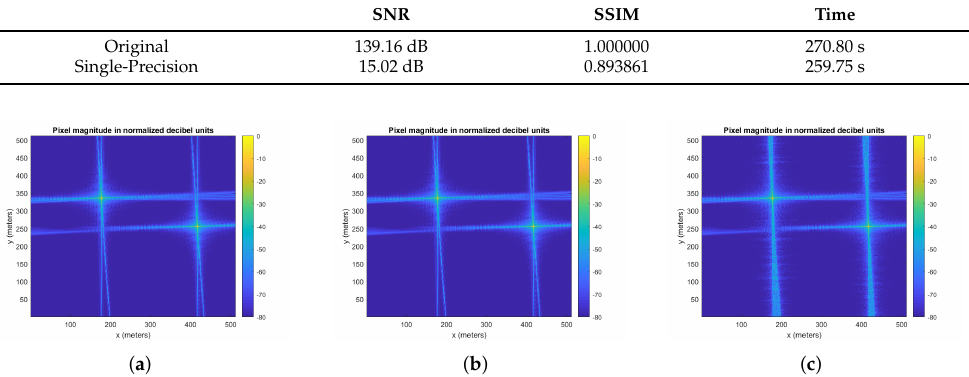
Figure 17. Small dataset of the PERFECT suite in three versions: golden reference, original imple- mentation and single-precision only. ( a ) Golden reference of the small dataset of the PERFECT suite. ( b ) Small dataset of the PERFECT suite generated using the original provided code, with variables in double and single-precision. ( c ) Small dataset of the PERFECT suite generated using the original provided code, with variables in single-precision